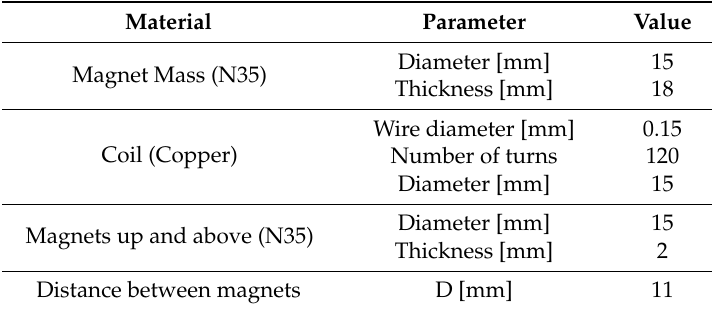
Table 2. Structural parameters and material properties of EM element in the analysis.